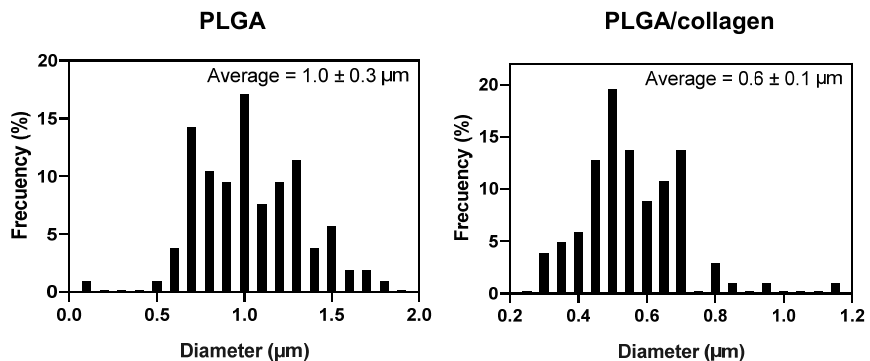
Figure 2. Fiber diameter histograms of corresponding PLGA and PLGA/collagen scaffolds.